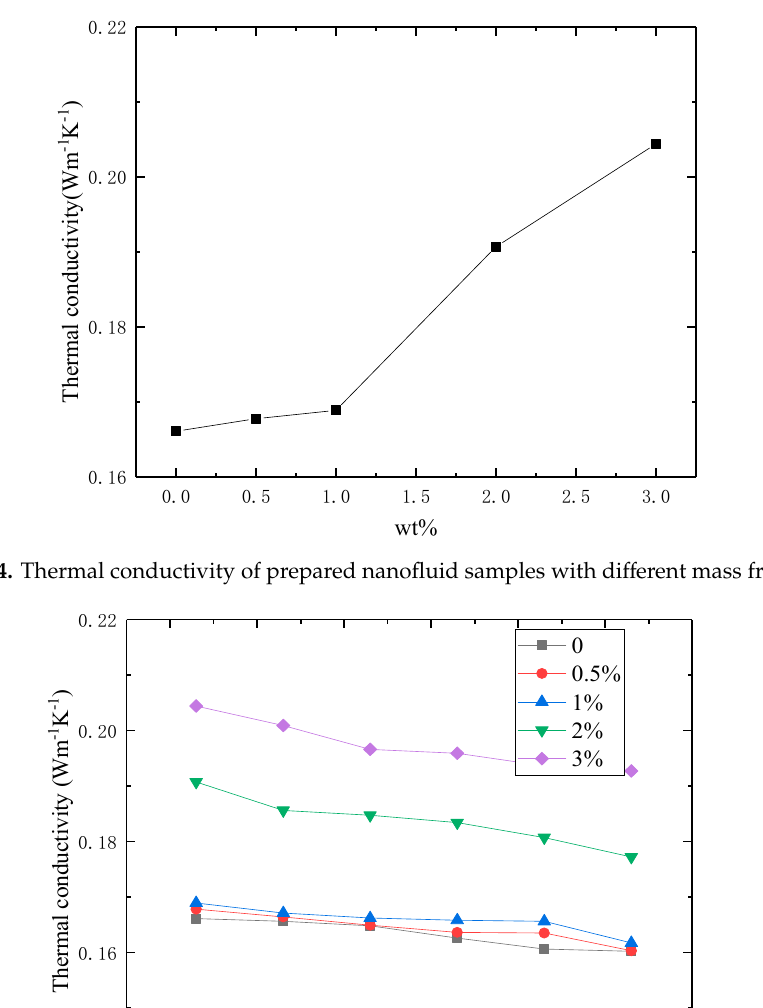
Figure 5. Thermal conductivity of prepared nanofluid samples at different temperatures.